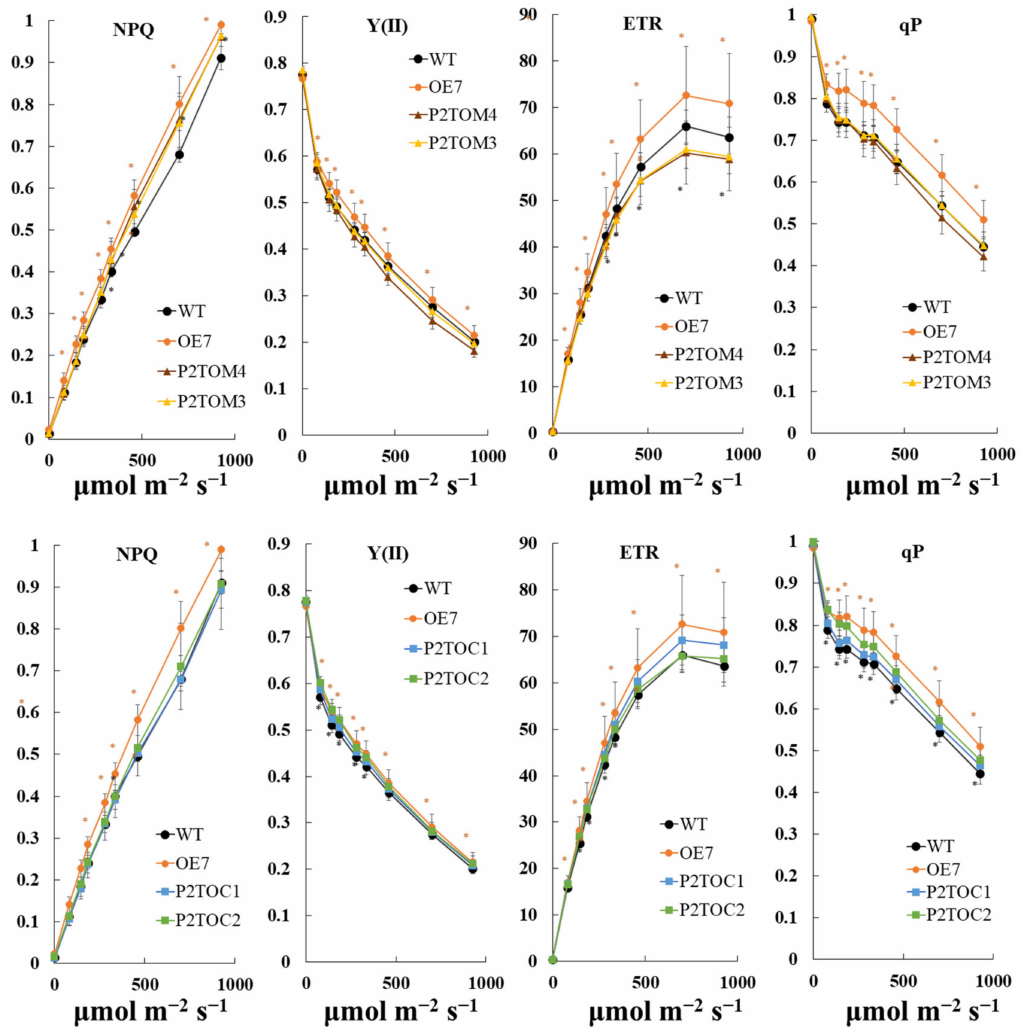
Figure 3. In vivo measurement of electron transport activity. Light density-dependent NPQ, Y(II), ETR, and qP of WT (black circles), OE7 (orange circles), P2TOC1 (blue squares), P2TOC2 (green squares), P2TOM3 (yellow triangles), and P2TOM4 (brown triangles) lines were acquired by MAXI-PAM. Twenty-day-old plants were dark-adapted for 1 h before measurement at 9 light densities (0, 81, 145, 186, 281, 335, 461, 701, and 926 µ mol m − 2 s − 1 ) with a duration of 3 min each. Values are mean ± SD ( n > 10 per line). Asterisks show significant differences between WT and the TOC/TOM lines according to t-test, * p < 0.05 (orange: OE7, black: P2TOM/P2TOC